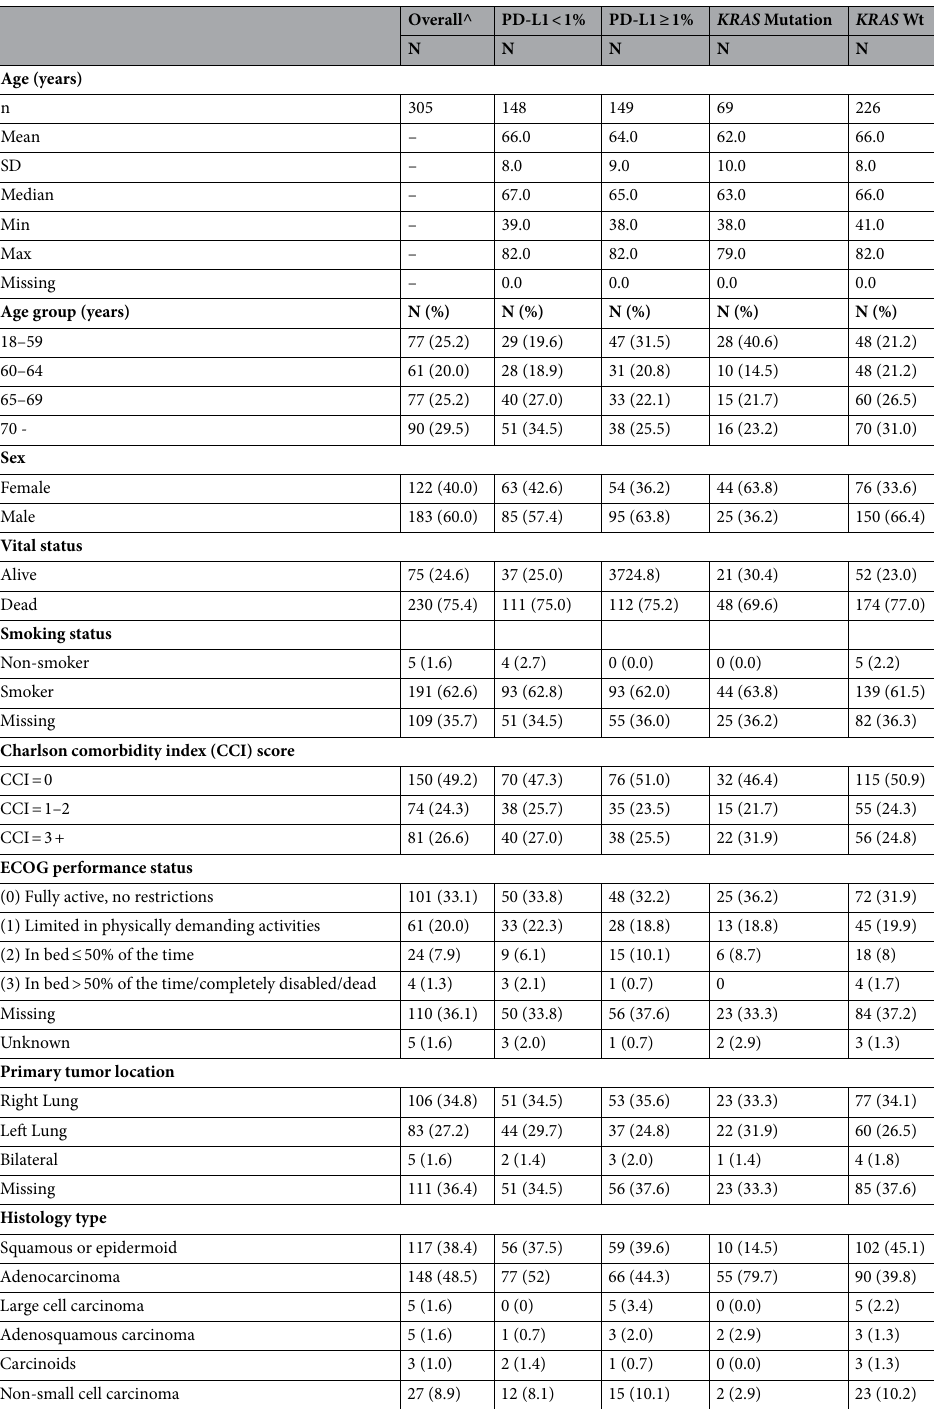
Table 1. Descriptive characteristics of the cohort of Stage III unresected NSCLC patients diagnosed 2000– 2013 and registered in the Danish Lung Cancer Group clinical database, according to tumor PD-L1 expression, and KRAS mutation status* *NSCLC: non-small cell lung cancer; PD-L1: programmed cell death ligand 1; KRAS: Kirsten rat sarcoma virus. ^In the cohort of 305 stage III unresected patients, 9 had a missing/invalid PD-L1 result; 10 had a missing KRAS